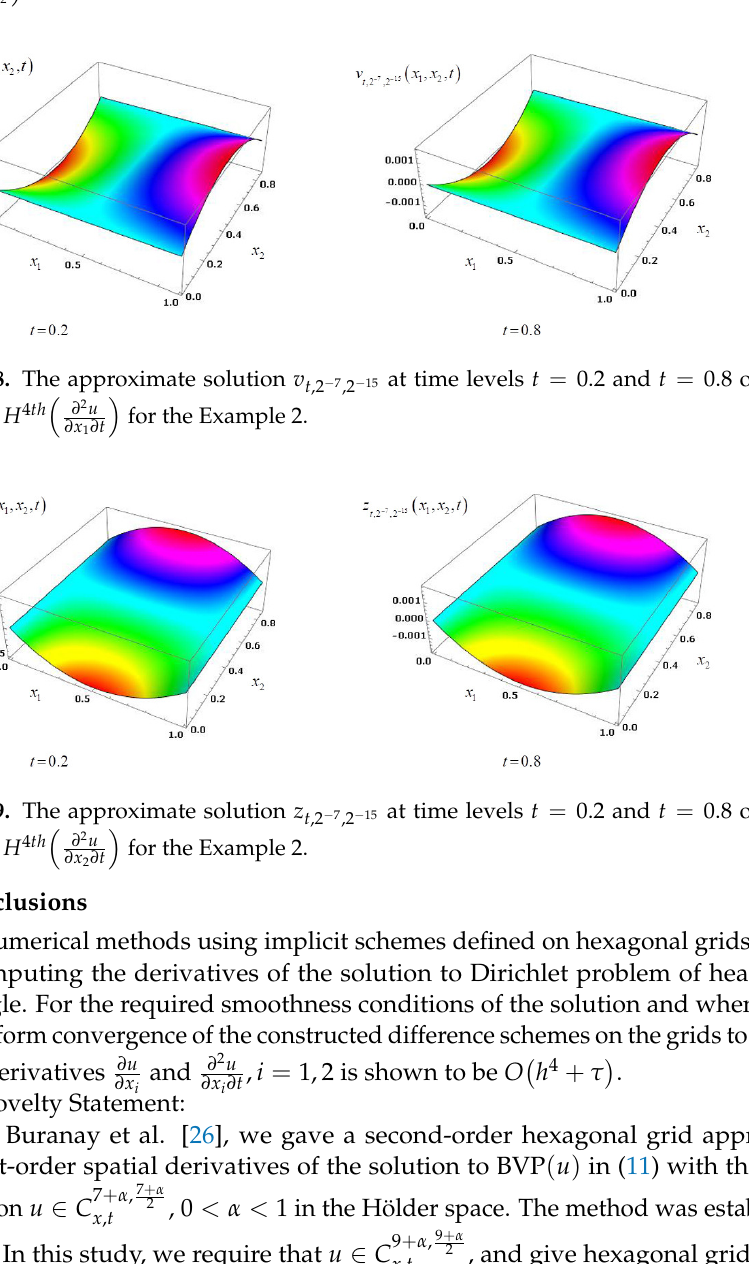
Figure 7. The approximate solution z 2 − 7 ,2 − 15 at time levels t = 0.2 and t = 0.8 obtained by the method (cid:16) (cid:17) ∂ u H 4 th for the Example 2. ∂ x 2